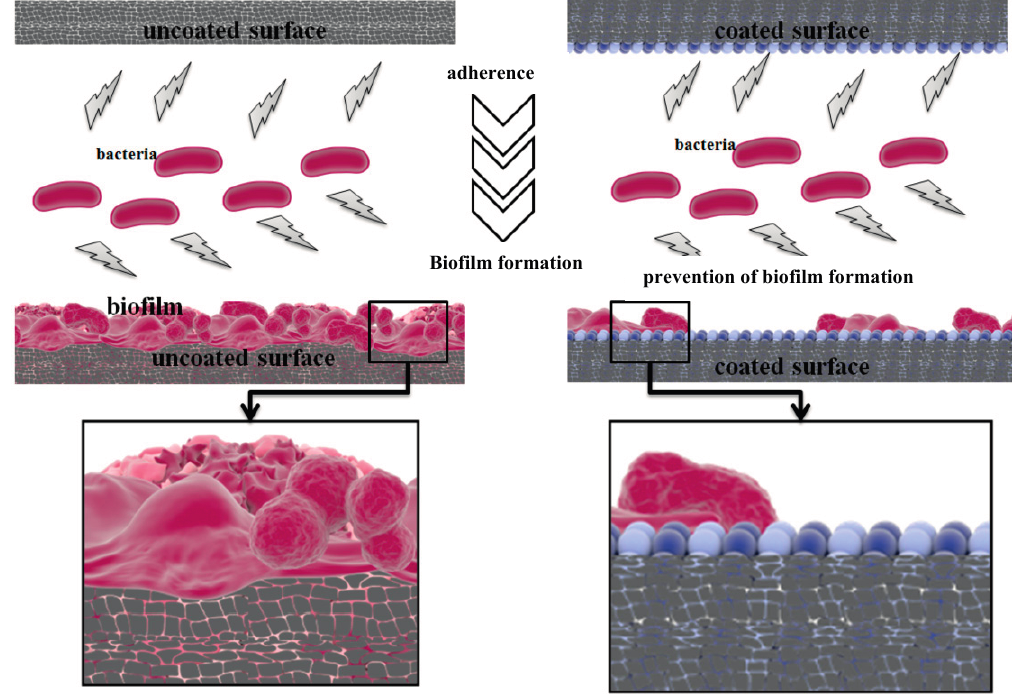
Figure 2. Schematic representation of microbial biofilm development in the presence and absence of functionalized bioactive magnetite